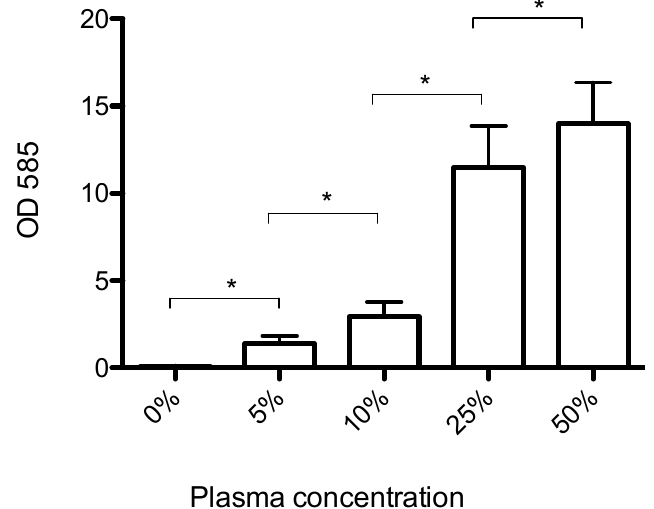
Figure 1. Mean biofilm biomass (±SD, n = 8), measured by crystal violet staining. USA300 formed very little biofilm in pure brain heart infusion (BHI), but the addition of human plasma led to increased biofilm formation in a dose-dependent manner. * significantly different ( p < 0.001).